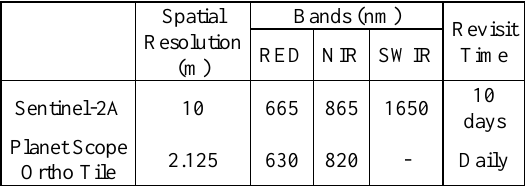
Table 3. Satellite Image Specification Parameters PlanetScope Ortho tile and Sentinel-2A datasets were selected according to their dates of acquisition following the closing and reopening of Boracay Island as well as the dry and wet seasons. High tide conditions for each dataset were also considered in order to avoid seagrass misclassification.